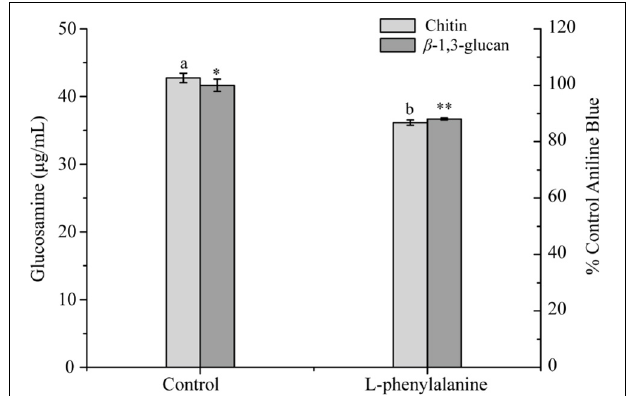
FIGURE 7 | Chitin and β -1,3-glucan concentrations in G. lucidum [the different superscript letters (a, b) and symbols ( ∗ , ∗∗ ) in each column indicate significant differences at the P < 0.05